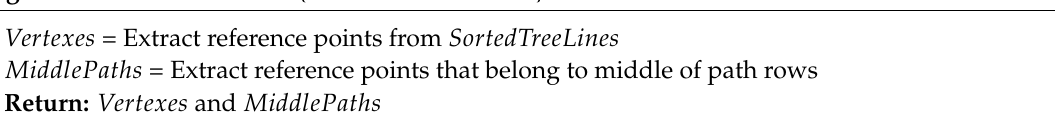
Algorithm 8 ReferencePoints{ Path SortedTreeLines